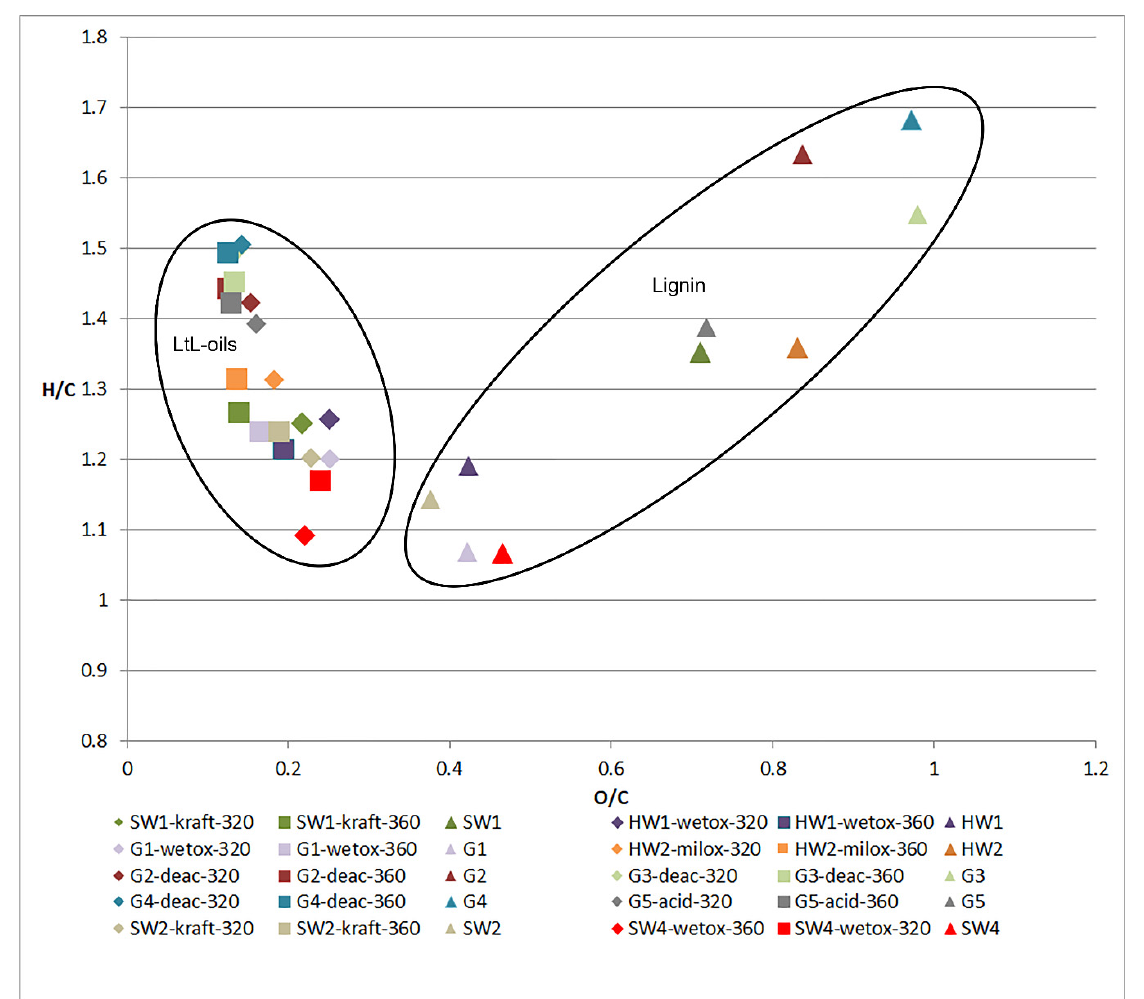
Figure 8. Van Krevelen plot displaying the oxygen to carbon ratio ( x -axis) and hydrogen to carbon ratio ( y -axis) of samples of lignin feedstock and LtL-oils. The ratios are based on mol% (all samples were analyzed in duplicates and presented in this plot as an average of the two analyses. Where replicate experiments were performed, the average of the experiments in question is presented in this plot).